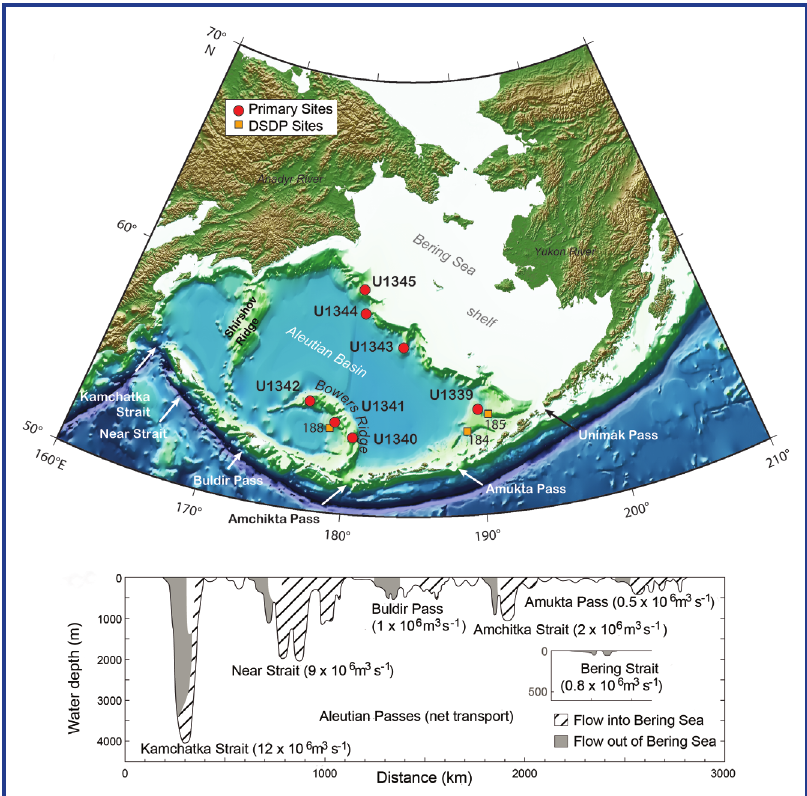
Figure 1. Map illustrating the locations of the seven sites drilled and cored during IODP Exp. 323 in the Bering Sea, along with cross-sections of the passes with volume transport (Sv) in the Aleutian Island arc and the Bering Strait. Note that the horizontal and vertical scales of the Bering Strait are twice that of the Aleutians (from Stabeno et al., 1999; Takahashi,